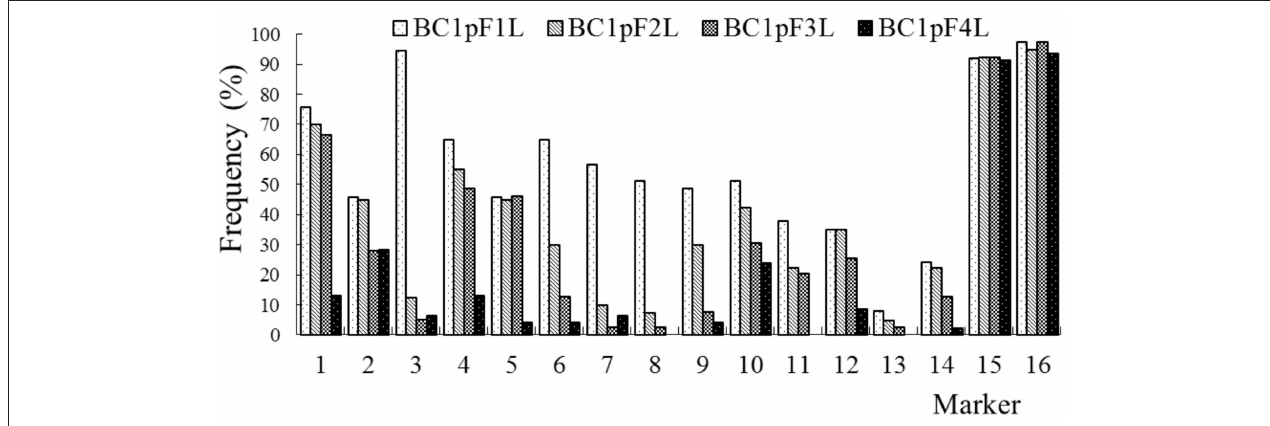
FIGURE 12 | Frequency of the marker specific to the C-chromosome of Brassica napus in the first (BC1pF1L)- to fourth (BC1pF4L)-generation progenies of BC1. BC1pF1L to BC1pF4L are the glufosinate-tolerant first- to fourth-generation progenies of the first backcross generation (BC1) obtained from F1L × wild Brassica juncea . F1L indicates the glufosinate-tolerant F1 hybrids obtained from wild B. juncea × glufosinate-tolerant transgenic oilseed rape. Progenitors in front of the × are always the maternal plants, and progenitors after the × are always the paternal